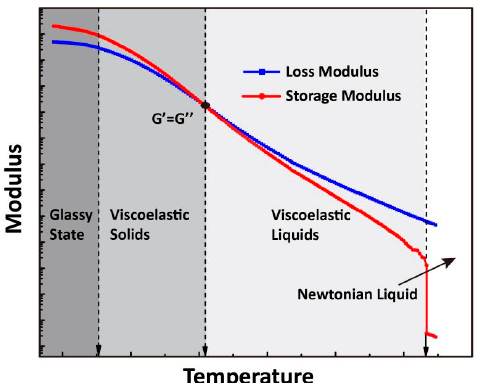
Figure 2. Four processes of asphalt binder mechanical state changing with temperature (the loss moduli approach the maximum plateau over the whole range of temperatures, the corresponding temperature is the glass transition temperature T g ; at temperature when G’ = G’’, viscoelastic asphalt transforms from viscoelastic solid to viscoelastic liquid; with G’ of asphalt decreases rapidly, asphalt changes from viscoelastic liquid to pure viscous Newtonian fluid) [23].